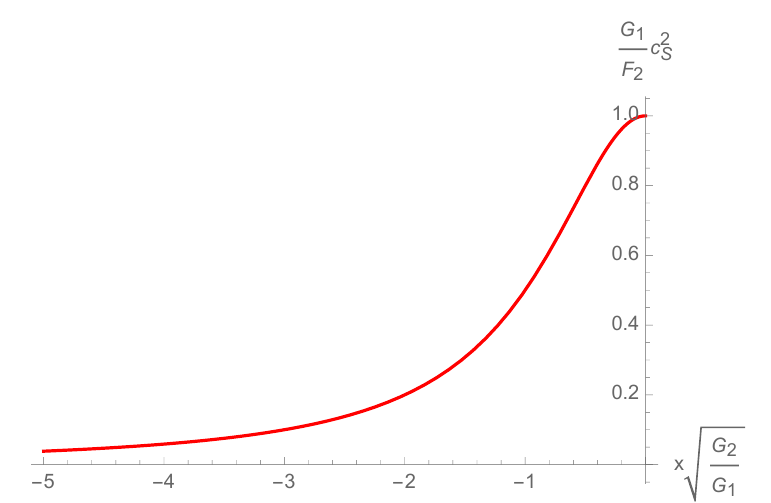
Figure 2 . The behavior of the c 2 , as a typical time-dependent coe(cid:14)cient in the dispersion relation, S as a function of time when sign( G 1 G 2 ) > 0. In this case the speed of sound, and other coe(cid:14)cients of the dispersion relation, approach zero and a constant value in in(cid:12)nite past and future.